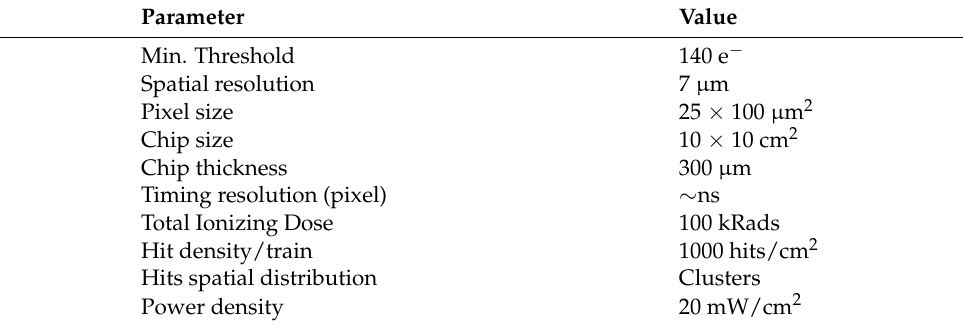
Table 1. Target specifications for 65 nm prototype. Parameter Value Min.